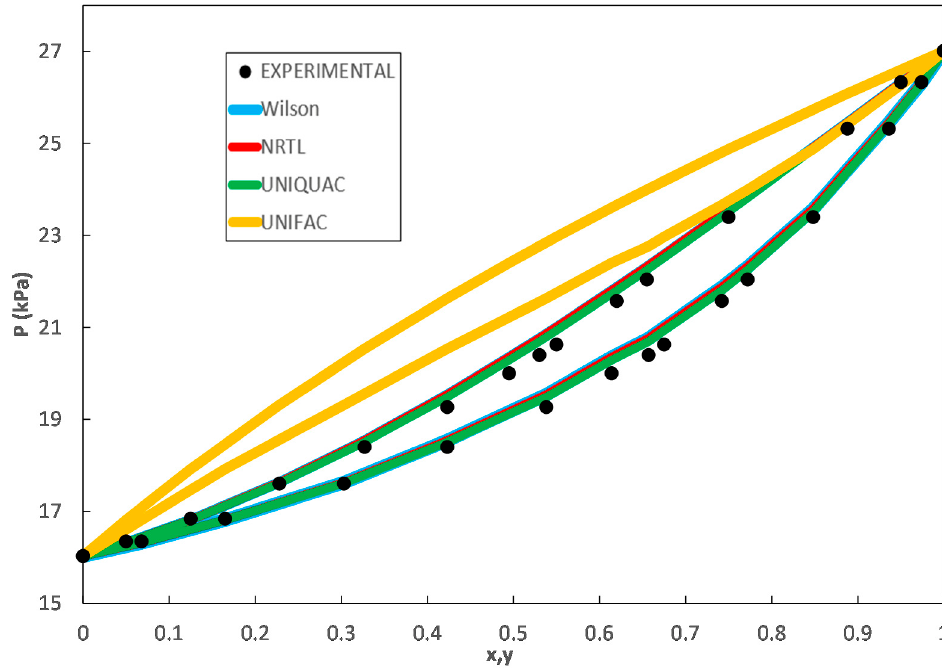
Figure 1. Experimental [12] and predicted P-xy diagram for THF(1) + Benzene(2) at 303.15 K using